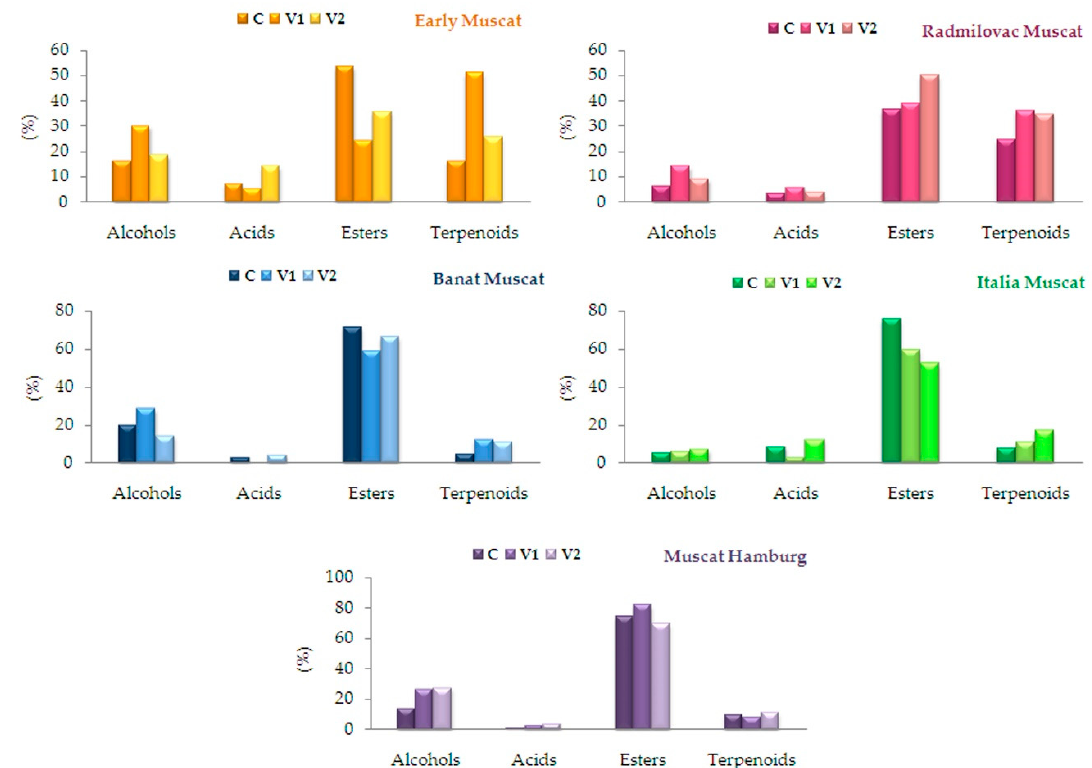
Figure 1. Changes of relative abundance of aromatic compound total content in grape brandies in different experiments; C—control (no enzyme), V1 and V2—0.3 g and 0.7 g of pectolytic enzyme per kg of grape, respectively.